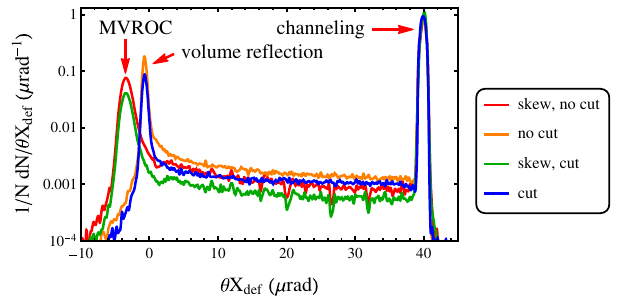
FIG. 10. The deflection angle distribution behind a bent crystal of 5 cm long for planar channeling in vertical and skew (110) crystal planes of 50 TeV protons. The bending angle it 40 μ rad and 53 . 3 μ rad for vertical and skew crystal planes respectively. The parameters of crystal cut are calculated according to [29].